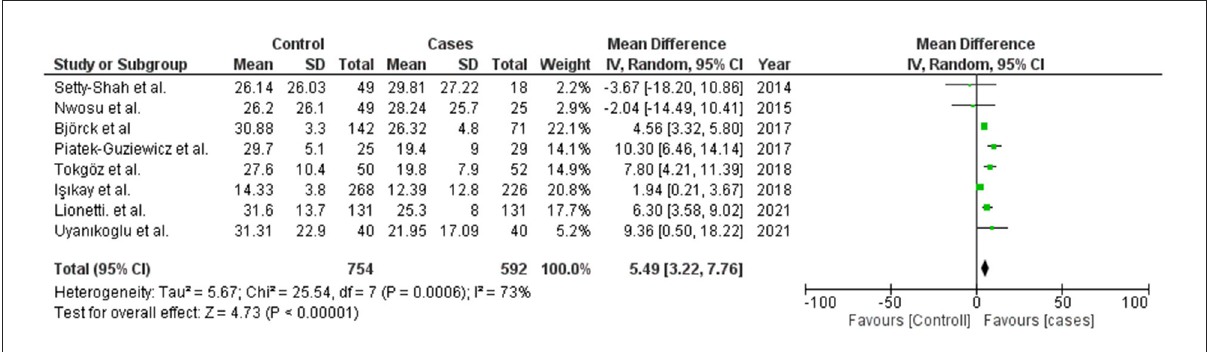
FIGURE2 Forest plot to show meta-analysis of vitamin D serum concentration in CD patients and